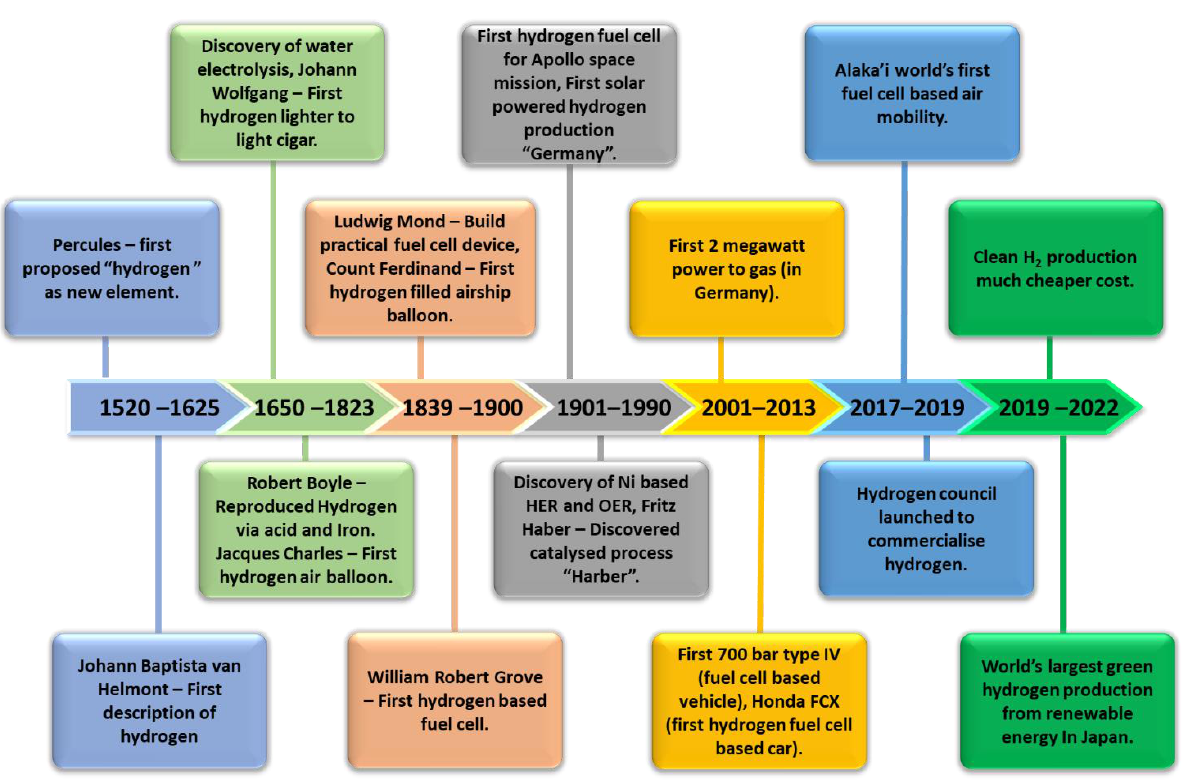
Figure 1. Timeline on the development of H 2 utilization as fuel.